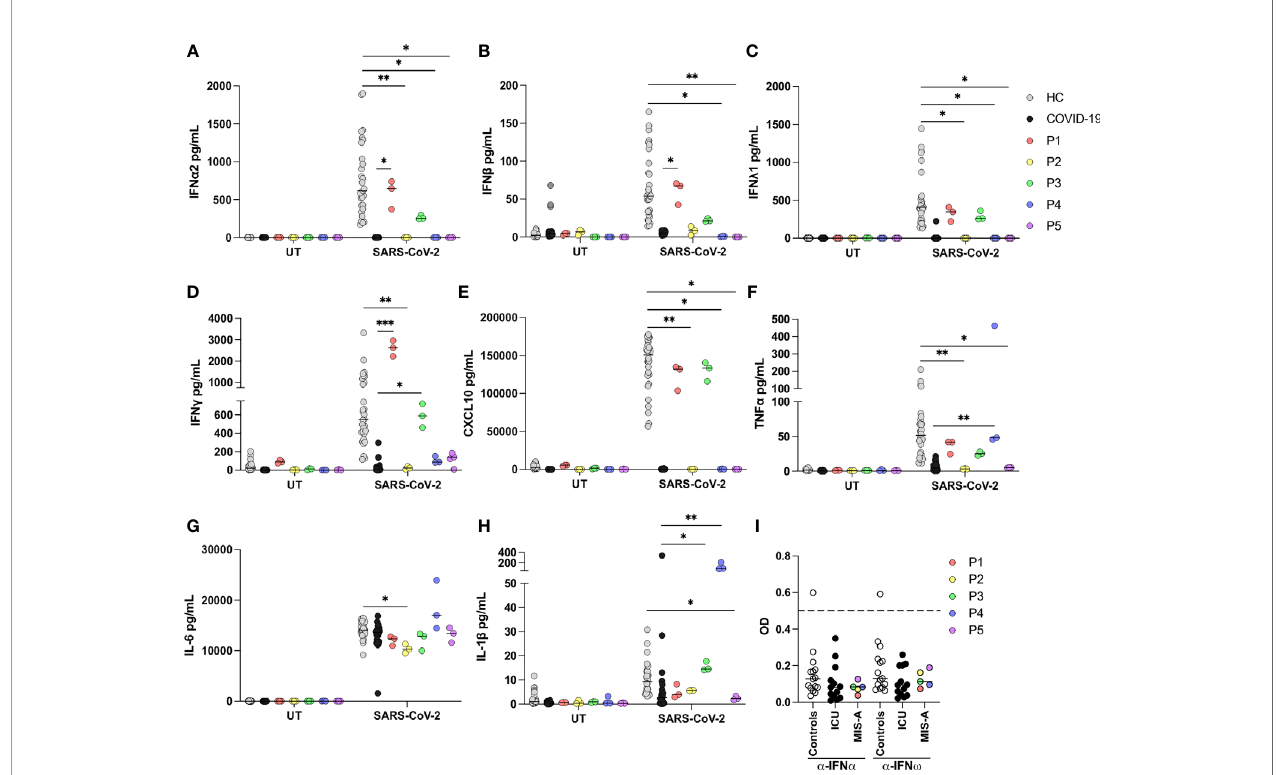
FIGURE 2 | Antiviral and in fl ammatory responses of patient PBMCs in response to SARS-CoV-2 infection. (A – H) Patient (P1-P5), healthy controls (HC) (n=5) and COVID-19 intensive care unit (ICU) patient (COVID-19) (n=9) peripheral blood mononuclear cells were left untreated (UT) or infected with SARS-CoV-2 at a multiplicity of infection of 0.5 for 24 h. Induction of IFNs and proin fl ammatory cytokines was measured in supernatants by U-plex mesoscale technology. Data are pooled from two independent experiments, but the experiment was performed only once for each patient due to limited patient material. All stimulations were done in triplicate in the individual experiments. (I) Autoantibodies against IFN a and IFN w measured in serum from patients, healthy controls (n=15) and COVID-19 ICU patients (n=13) by ELISA, y-axis depicts blank-corrected OD450-630. Values above 0.5 (dashed line) are considered positive. Statistical differences were calculated using Kruskal-Wallis with correction for multiple comparisons by Dunn ’ s test. *p < 0.05, **p < 0.01, ***p < 0.001. Each line, showing the result of a statistical test, compares one patient with the HC or the COVID-19 ICU group. Only comparisons between patient and controls, which are statistically different, are indicated on the